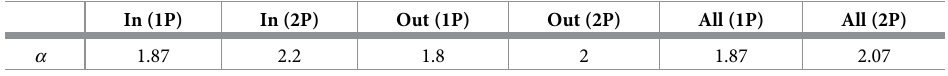
Table 3. Calculated values for α for the in, out, and overall degree distributions for the first (1P) and second (2P) periods.